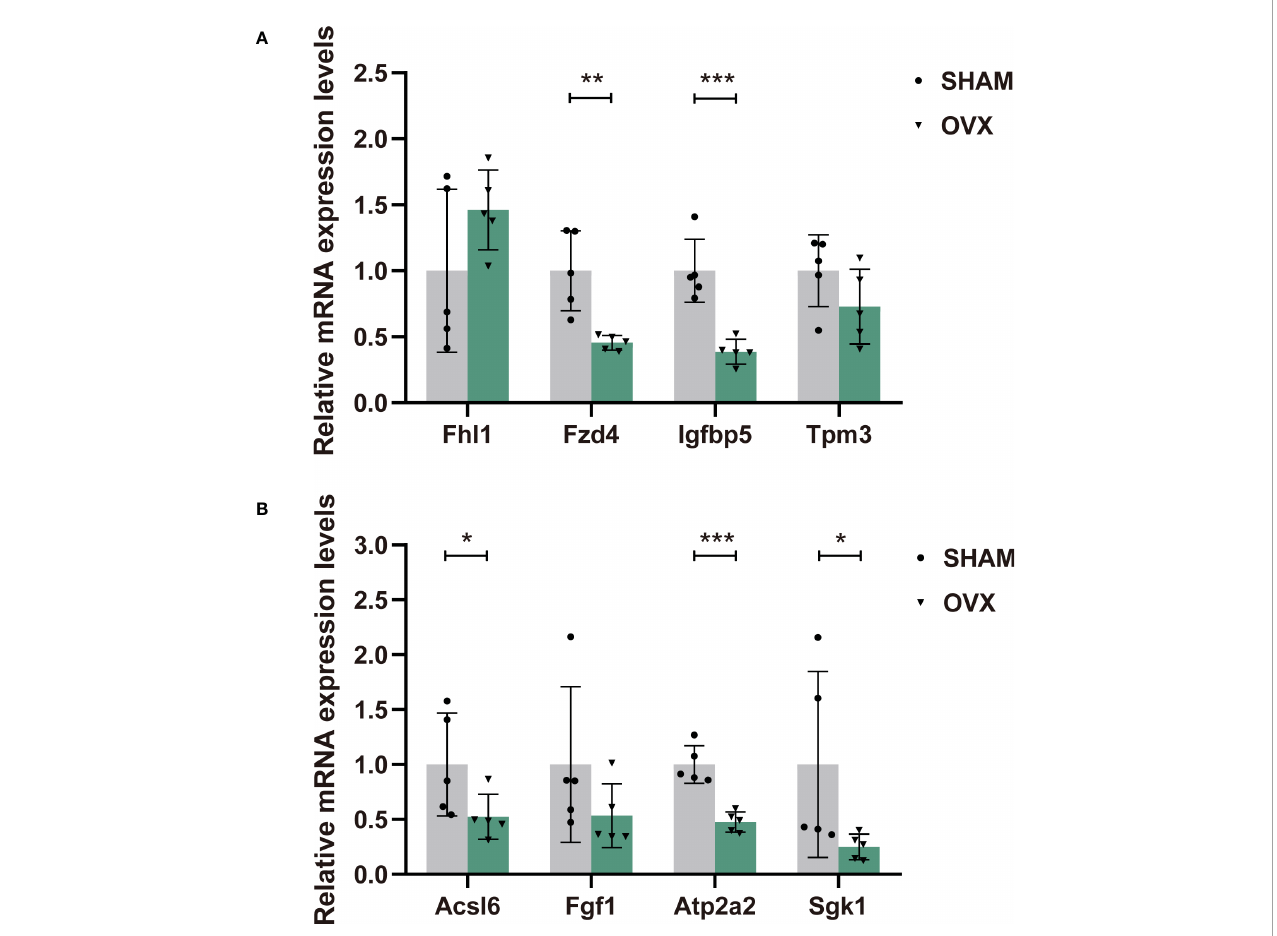
FIGURE 7 The relative expression levels of dif-mRNAs veri fi ed by RT-qPCR. (A) Fhl1, Fzd4, Igfbp5, Tpm3. (B) Acsl6, Fgf1, Atp2a2, Sgk1. n=5 in each group. Data are performed as mean ± SD. *P < 0.05, **P < 0.01, ***P <